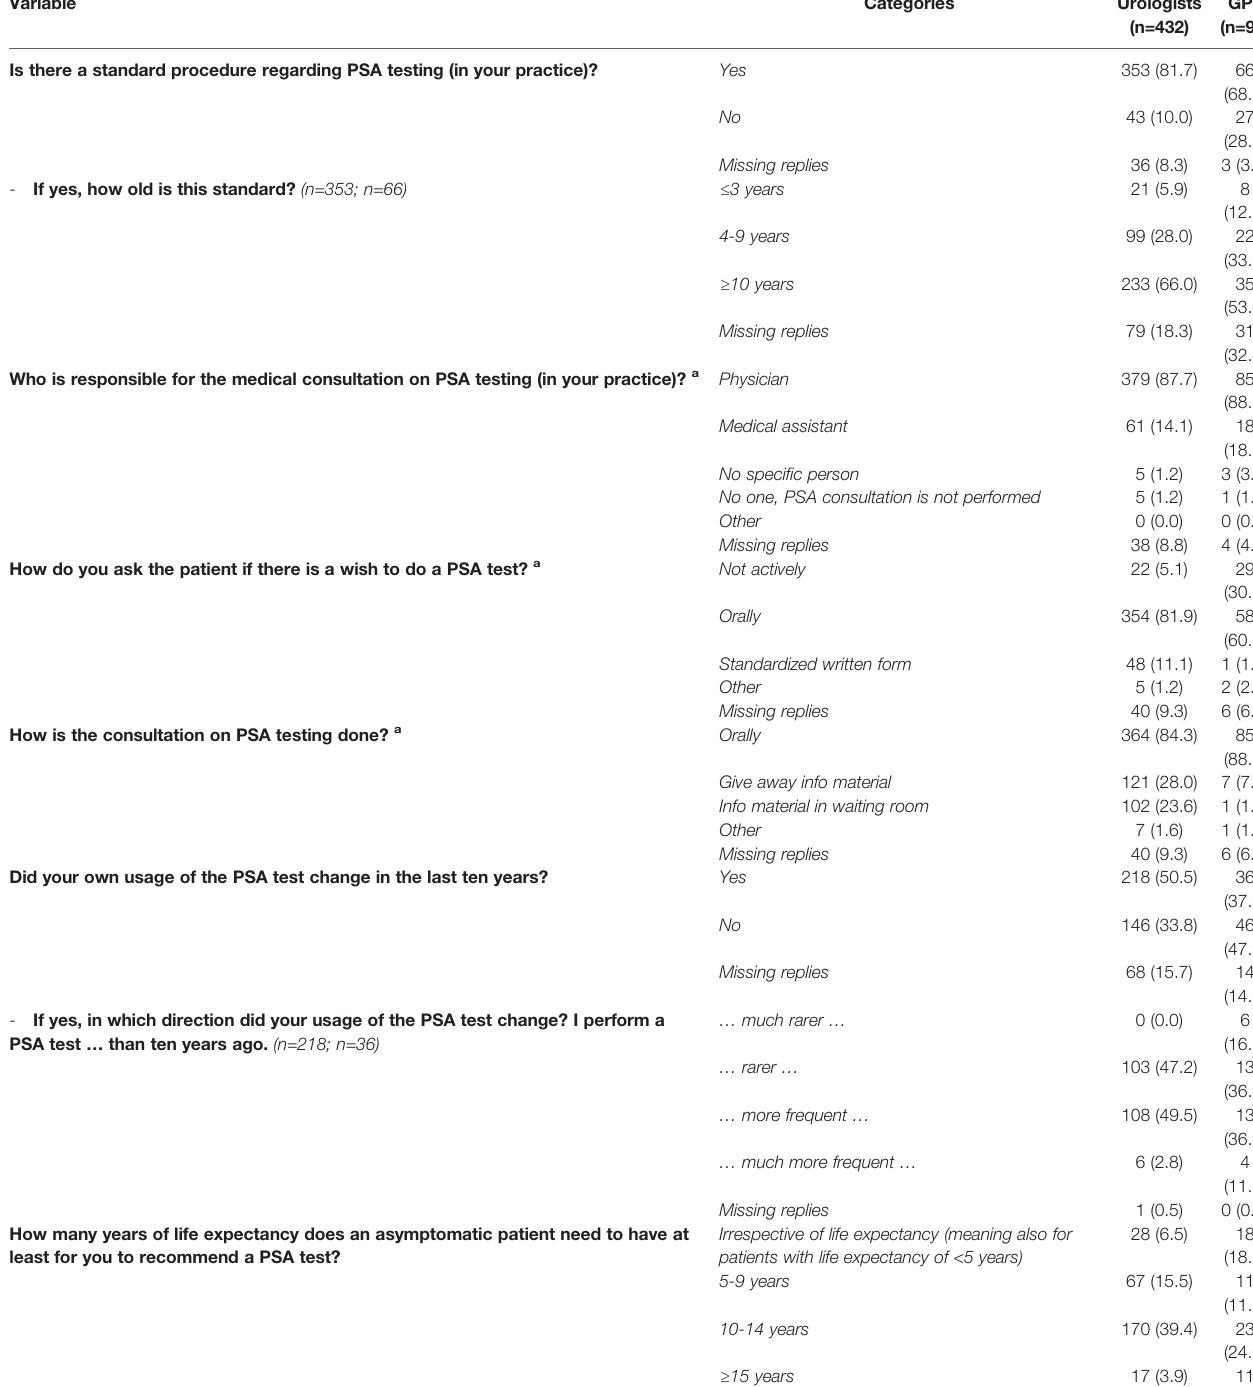
TABLE 4 | Use of prostate-speci fi c antigen testing among urologists and general practitioners [n